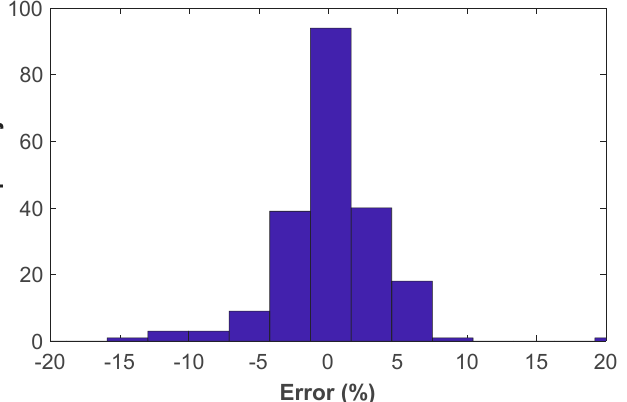
Figure 7. Histogram of discharged flow rate error frequencies simulated with the developed model. These data indicate that most of the errors fit the typical error of the volumetric meter acting as a flowmeter. Additionally, it should be considered that the measured flow rate can often be very far from the nominal flow rate of the flowmeter, which means the average error is high, mainly for the cases of low flow rates, as shown in Figure